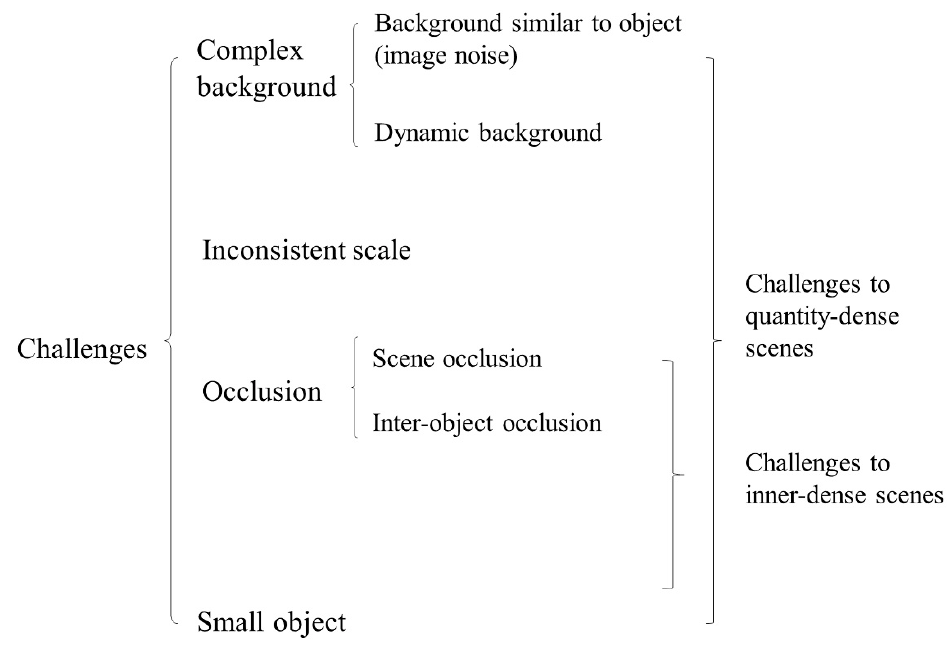
Figure 2. Challenges in dense scenes in agriculture.